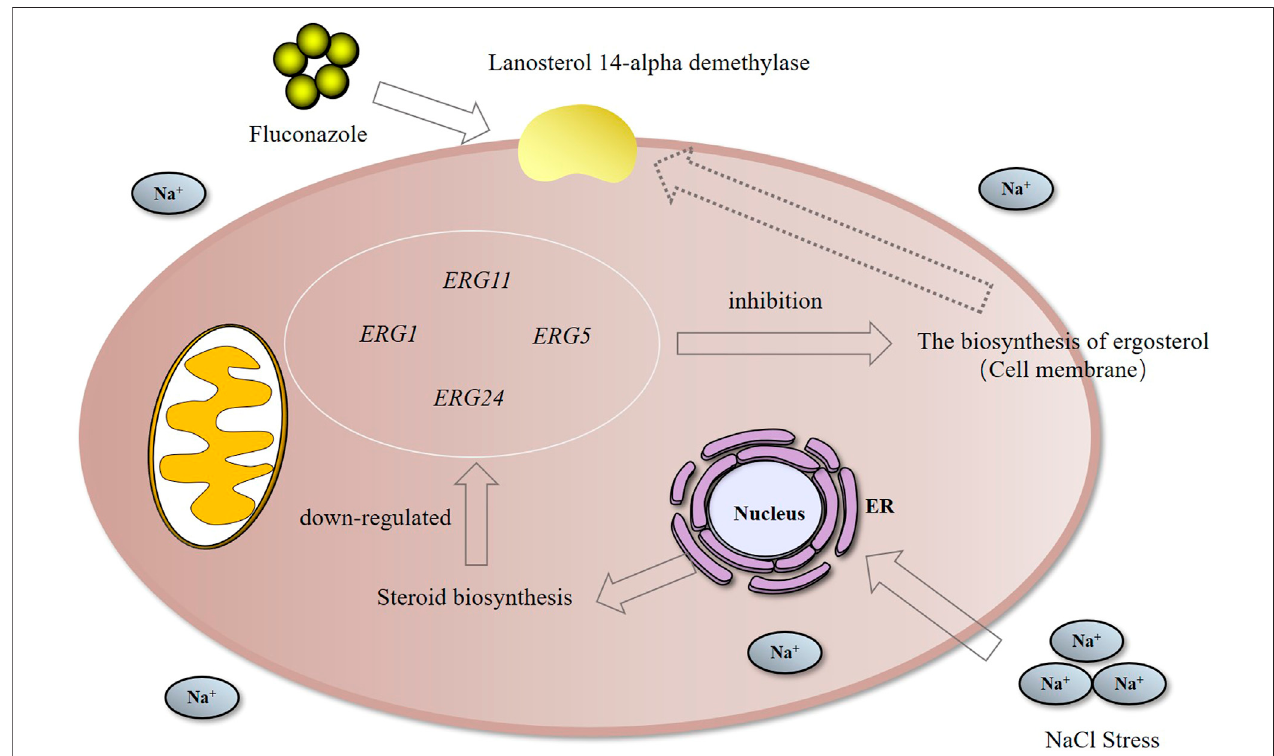
FIGURE 5 | Drug resistance of GXDK6 to fl uconazole under NaCl